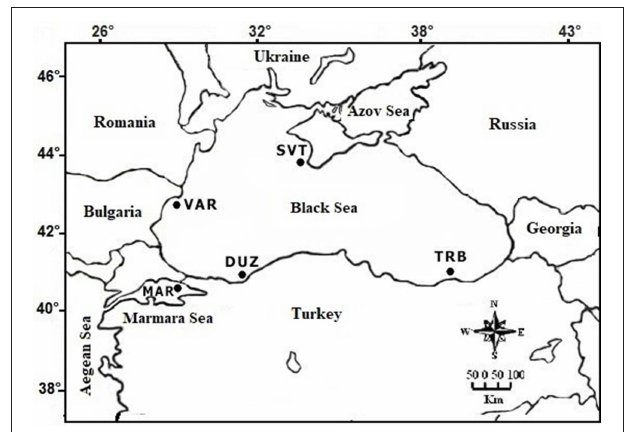
FIGURE 1 | Locations of S. maximus sampling sites: TRB (Trabzon coast); DUZ (Duzce coast); VAR (Bulgarian Varna coast); SVT (Russian Sevastopol coast); MAR (the Marmara Sea